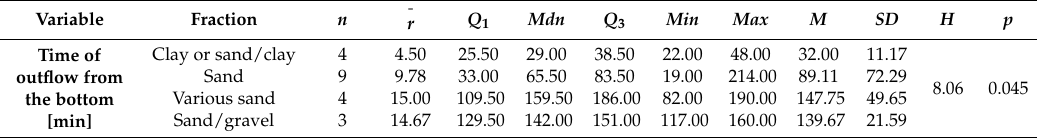
Table 7. Characteristics of the time of drilling fluid outflow for specific fractions — Kruskal-Wallis rank difference test.